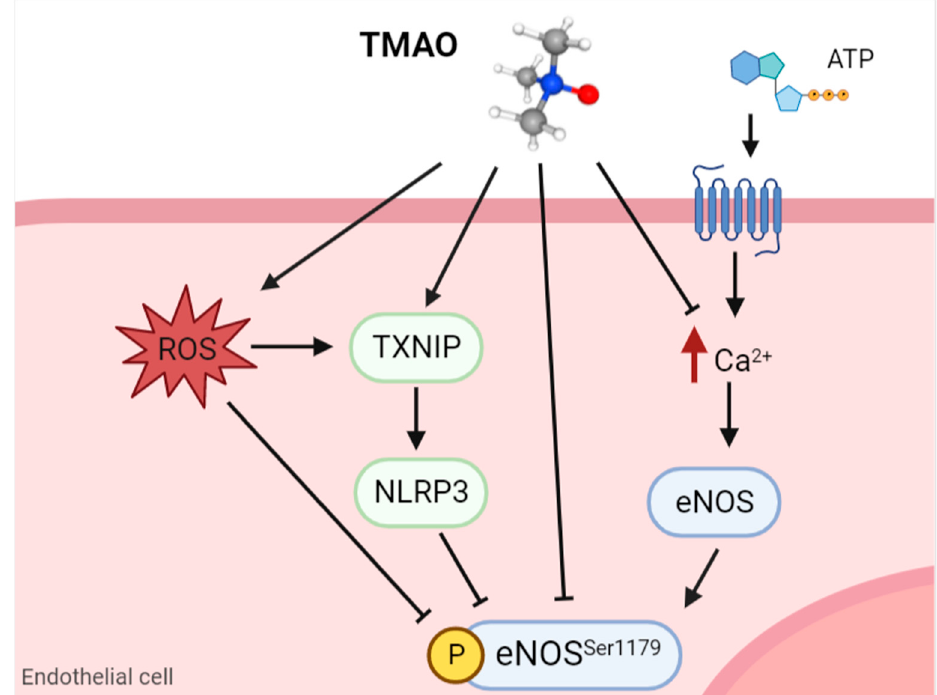
Figure 3. Schematic representation of how TMAO can reduce eNOS activity in endothelial cells. TMAO can directly inhibit eNOS phosphorylation or it can indirectly modulate its activity through the increase of ROS, activation of NLRP3, or decrease in intracellular calcium in purinergic response. TMAO: trimethylamine N-oxide; ATP: adenosine triphosphate; ROS: reactive oxygen species; TXNIP: thioredoxin-interactive protein; NLRP3: nucleotide-binding domain, leucine-rich-containing family, pyrin domain-containing-3; eNOS: endothelial nitric oxide synthase. Image created with Biorender.com.